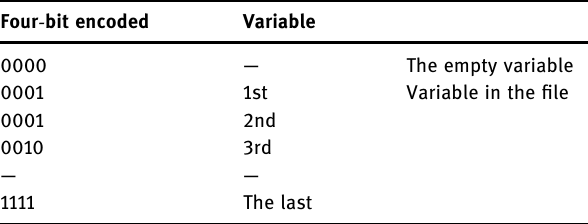
Table 2: Four - bit encoded input/output variables